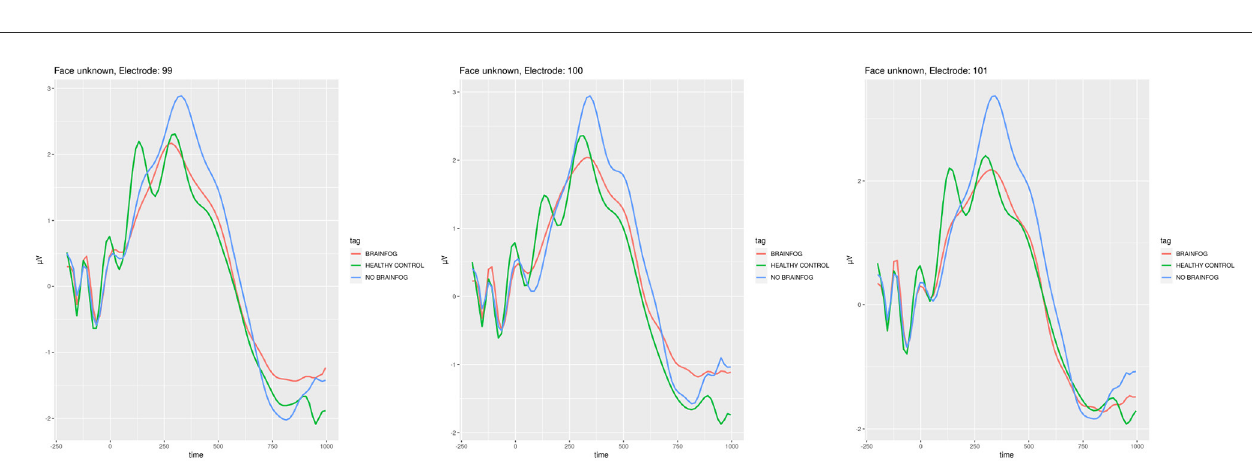
FIGURE5 ERP plots generated for the electrodes E99 , E100 , and E101 that showed the smallest cross-correlation in the face recognition experiment when the participants saw the unknown face . Red line—the participants that suffered from COVID-19 and with brain fog symptoms. Blue line—the participants that suffered from COVID-19 and without brain fog symptoms. Green line—the participants without COVID-19 episode. See also Tables 3–5 in Appendix